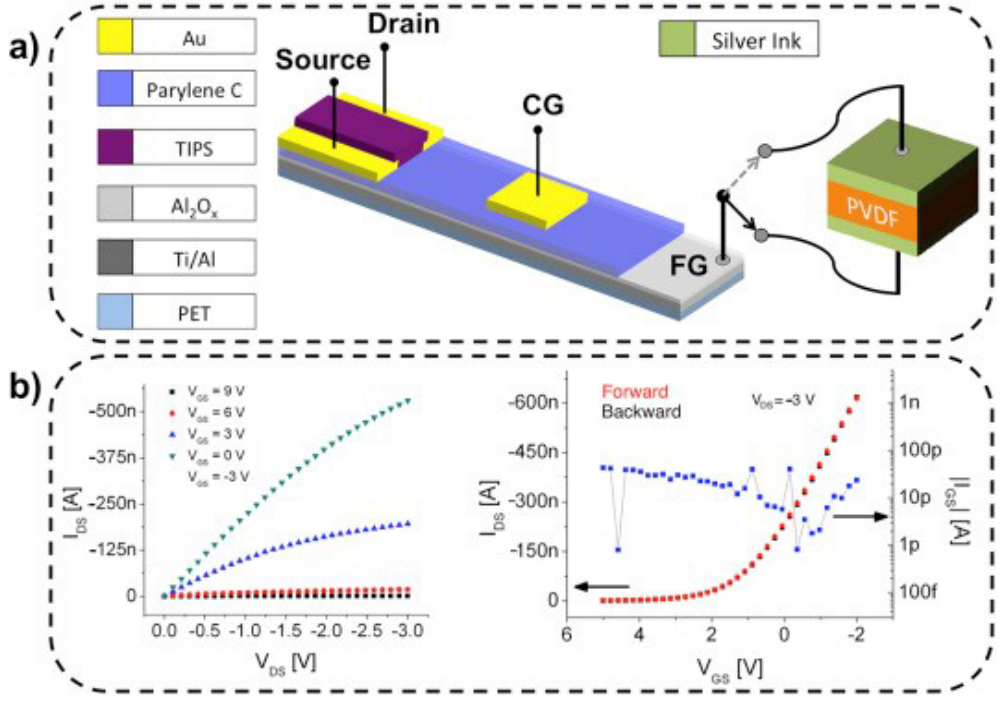
Figure 12. ( a ) The designed structure of the highly sensitive tactile sensor and ( b ) Output and input characteristics of designed device for pressure sensing [152].